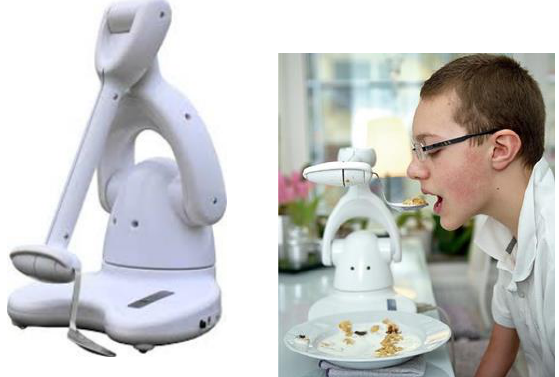
Fig. 1. Pictures of Bestic 1 (left) and 2